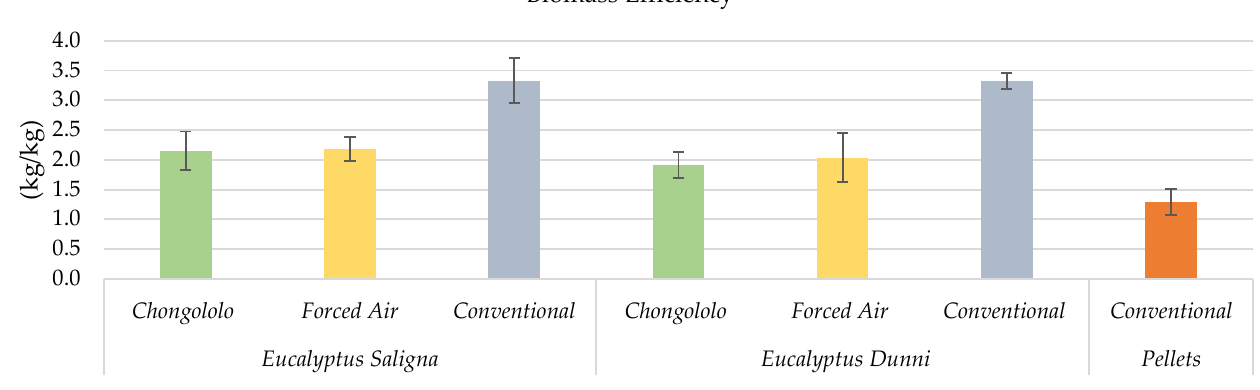
Figure 2. Efficiency in biomass consumption for different curing units.